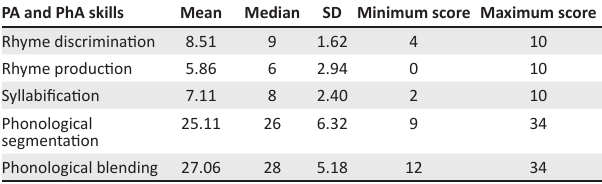
TABLE 2: Results of phonological awareness and phonemic awareness skills ( n =